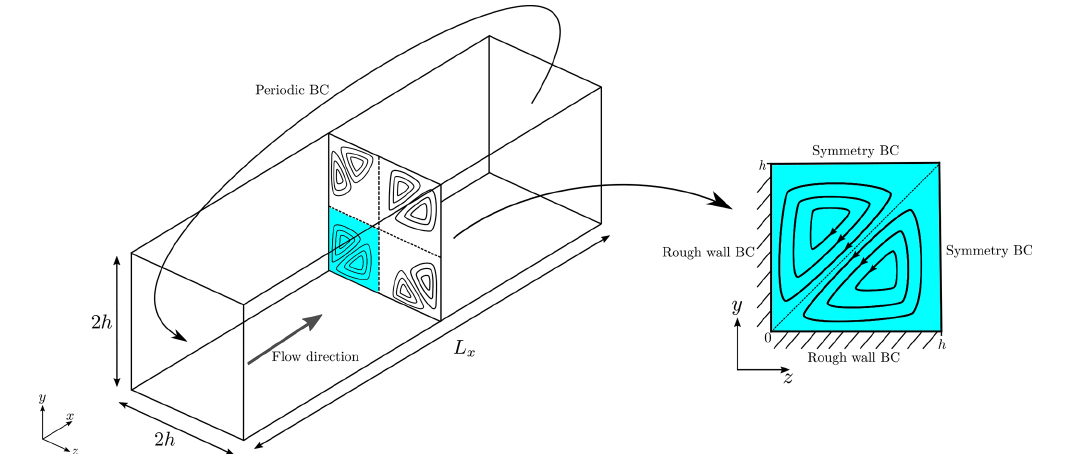
Figure 7. Square duct geometry and a cross-section showing the secondary corner flows. Sketch made with inspiration from Wu et al. (2016).